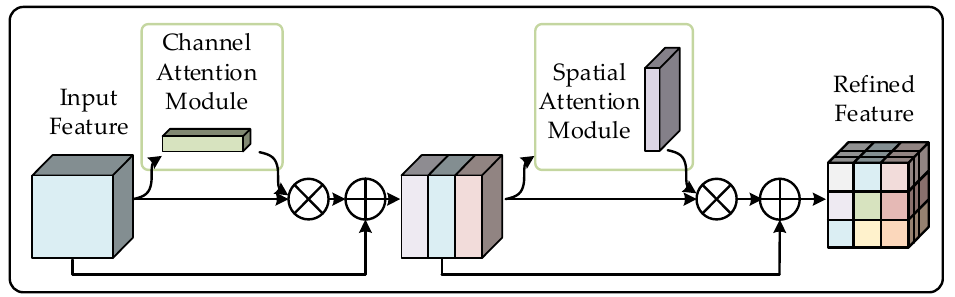
Figure 2. Structure of